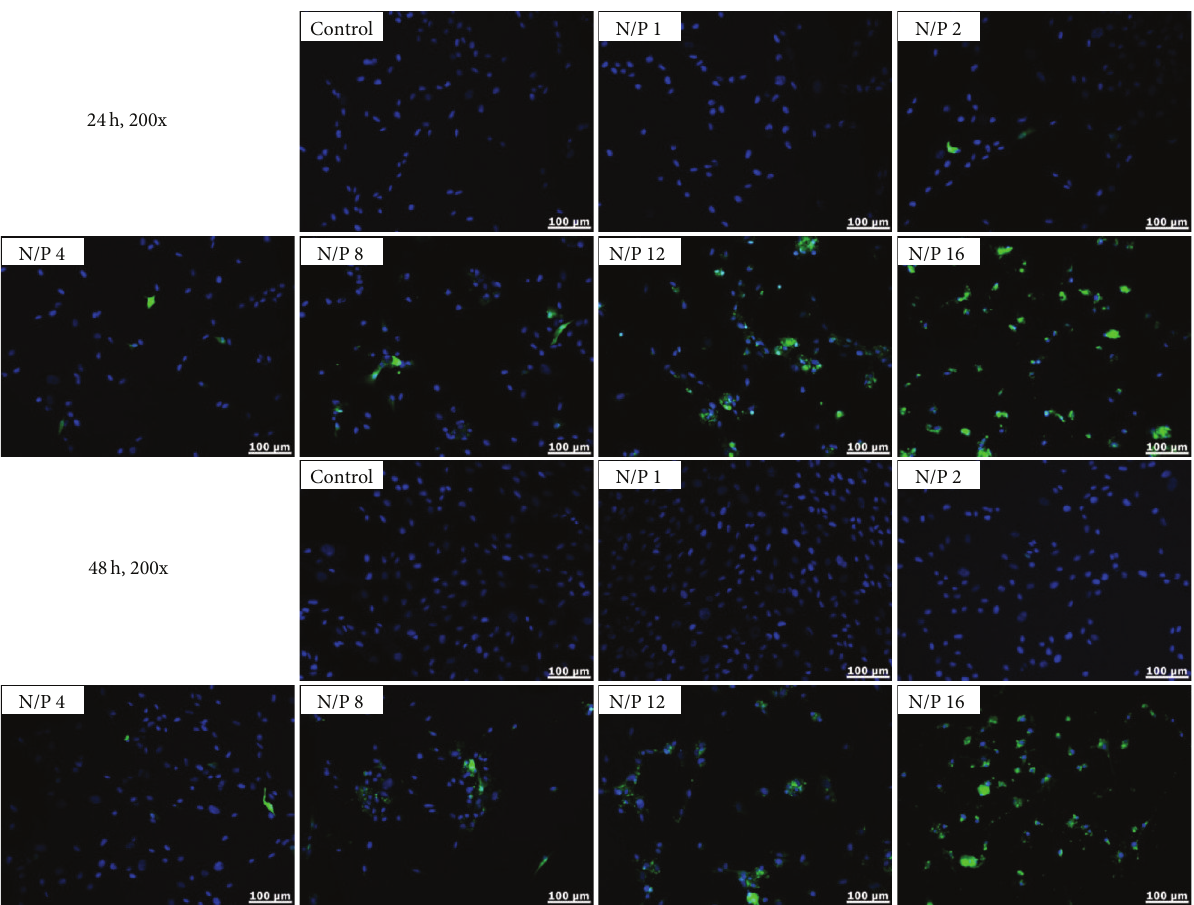
Figure 4: Fluorescence images of hTMSCs after treatment with DNA-PEI NPs. EGFP shows green fluorescence and the DAPI-stained nucleus is indicated as blue fluorescence. Magnification is × 200 and the scale bar represents 100 𝜇 m.